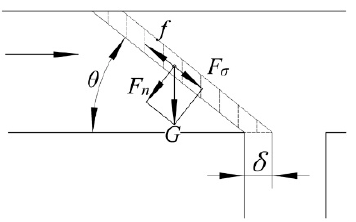
Figure 10. Effect of outlet distance on fertilizer amount uniformity.